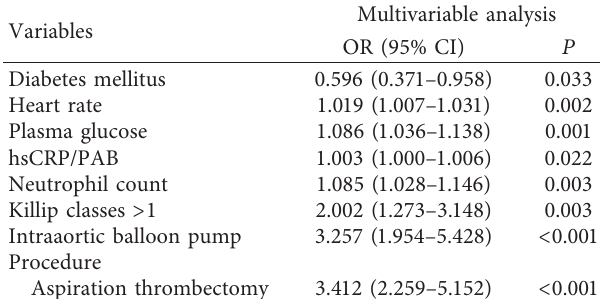
Table 2: Univariable analysis for no-reflow. Table 3: Multivariable analysis for